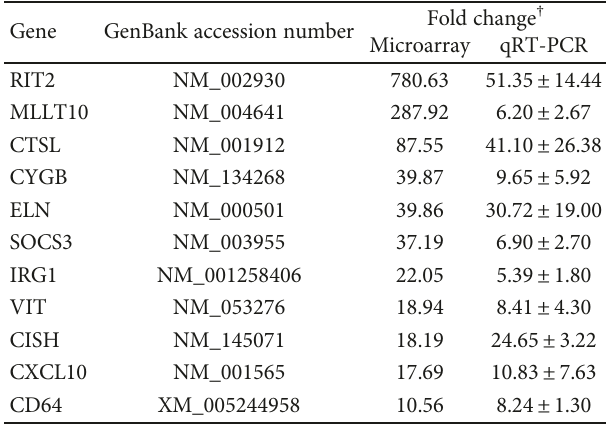
Fold change indicates the mean expression level of the gene in neutrophils coculturedwith Plasmodiumfalciparum -parasitizederythrocytesnormalized to that in neutrophils cocultured with normal red blood